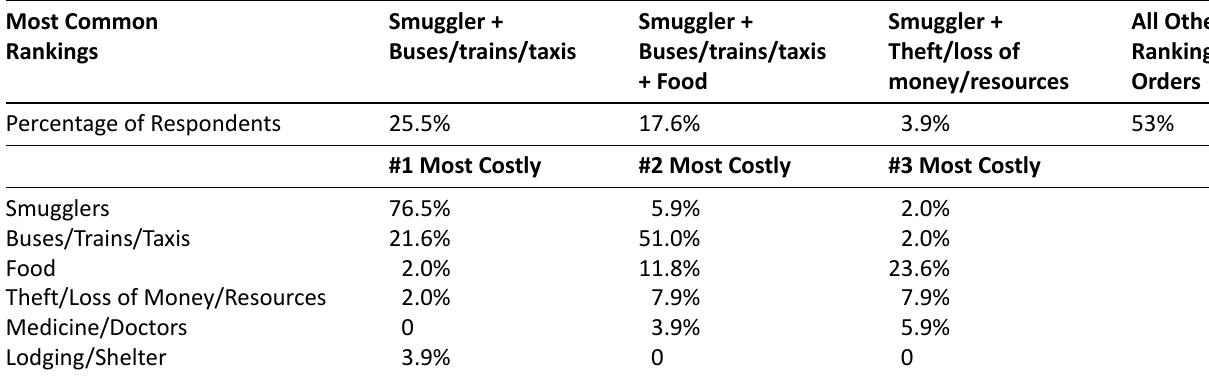
Table 1. Relative migration